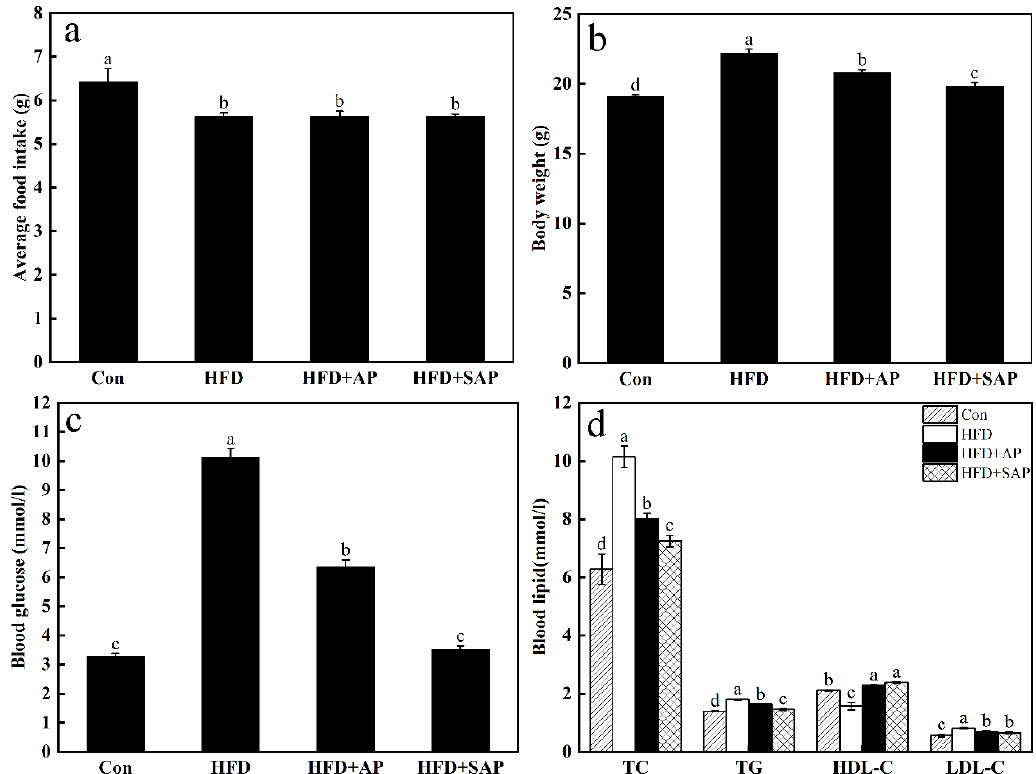
Figure 10. Animal experiments. ( a ) Effect of AP and SAP on average food intake. ( b ) Effect of AP and SAP on body weight. ( c ) Effect of AP and SAP on blood glucose. ( d ) Effect of AP and SAP on blood lipid.